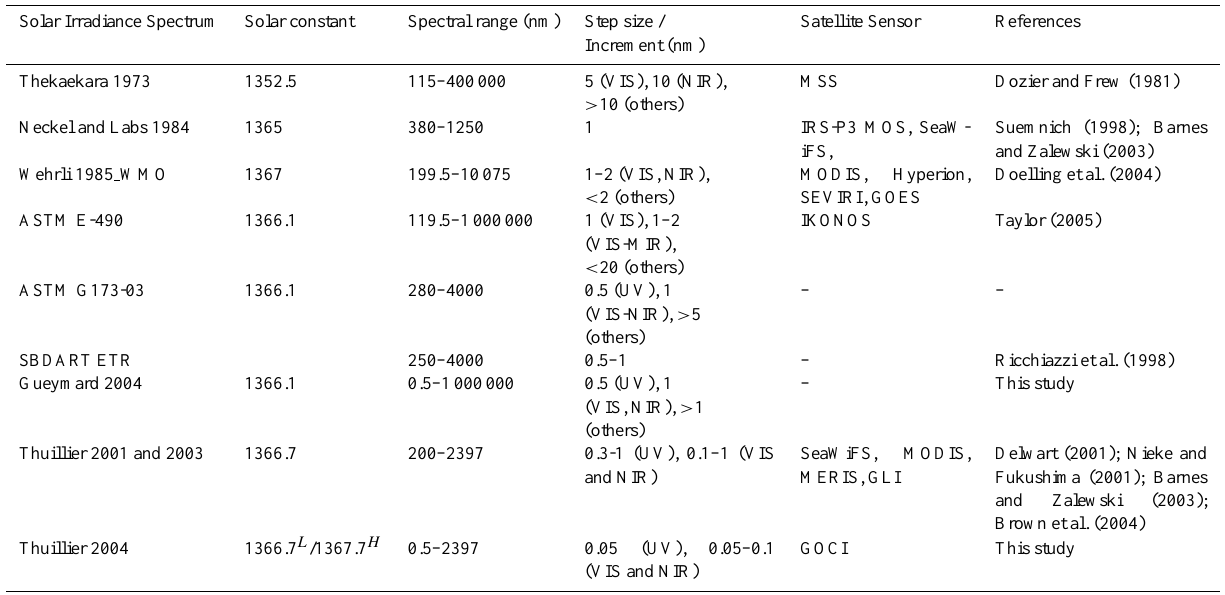
Table 1. Background of the applied solar irradiance spectra in various remote sensing